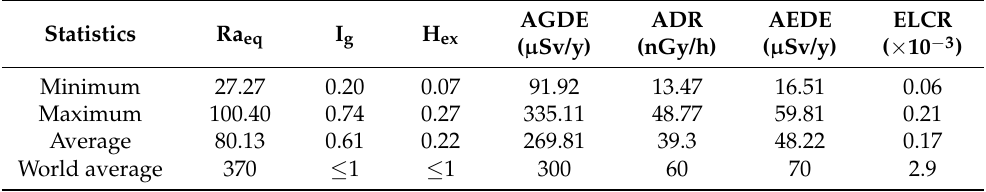
Figure 7. Distributions of radiological health risks and calculated parameters ADR, AGDE, AEDE, and ELCR. Table 3. The values of radiologic hazard parameters calculated for the soil samples of Kosovo.